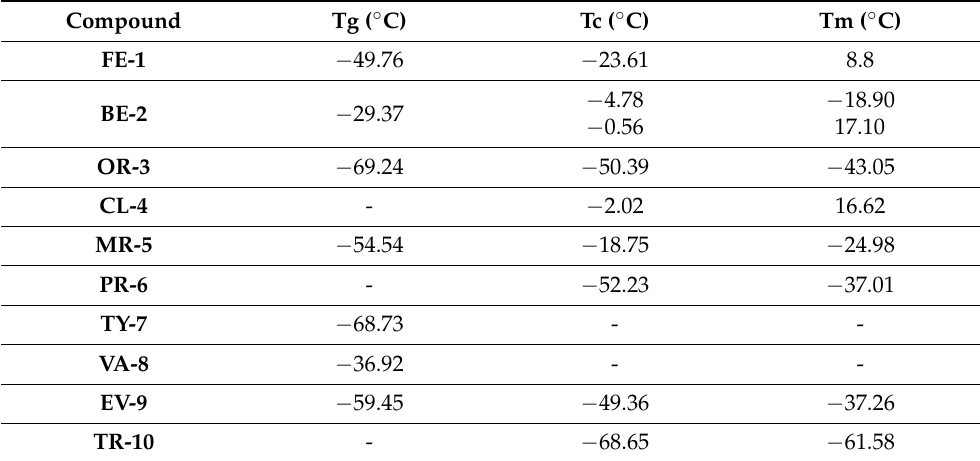
Table 2. DSC data for obtained ionic liquids.